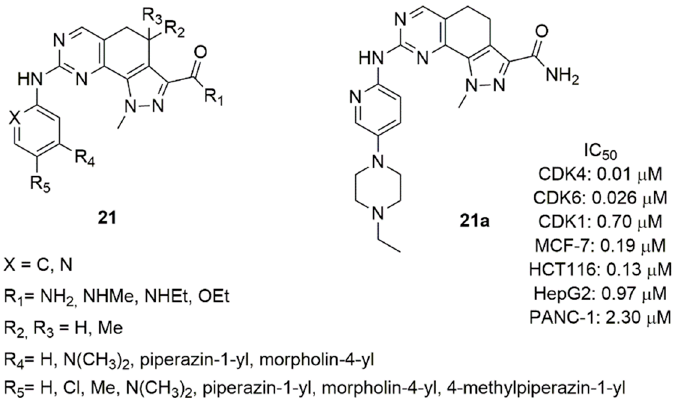
Figure 11. Structure of 4,5-dihydro-1H-pyrazolo[4,3-h]quinazoline derivatives. Compound 21a was the best one of this series, showing good activity on CDK4/6 (IC 50 CDK4 = 0.01 µ M, IC 50 CDK6 = 0.026 µ M) and high selectivity against CDK2 (IC 50 CDK2 = 0.70 µ M), anti-proliferative activity in MCF-7 cell line (IC 50 = 0.19 µ M) and other solid tumors (colorectal, liver, pancreatic), favorable pharmacokinetic parameters (T 1/2 , CL, AUC, V, Cmax).